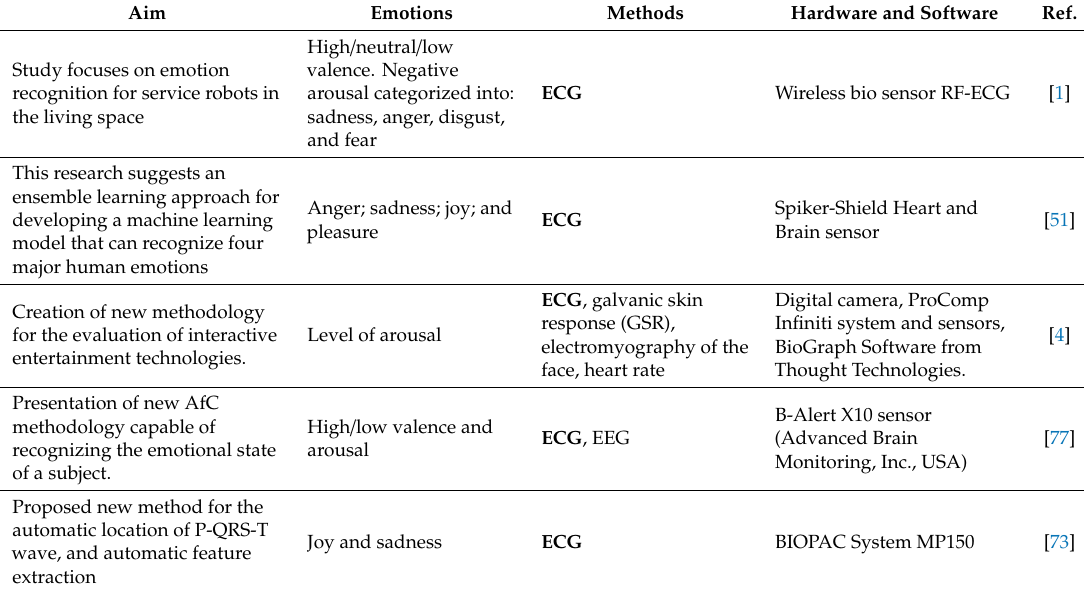
Table 4. Review of scientific researches focused on emotion recognition and evaluation using ECG. Aim Emotions Methods Hardware and Software